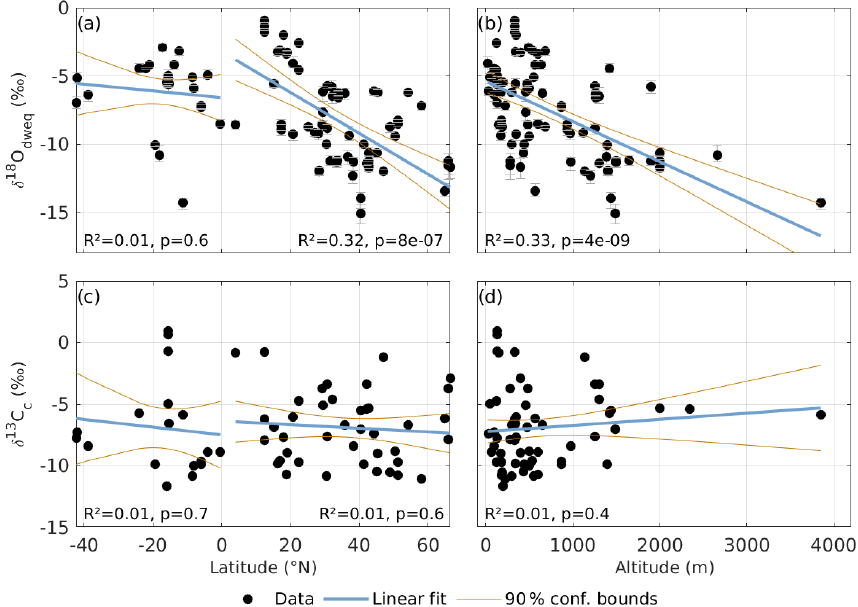
Figure 6. Speleothem δ 18 O dweq (a, b) and δ 13 C c (c, d) against latitude (a, c) and altitude (b, d) as provided by the SISALv2 database. Linear regression lines are shown separately for both the Northern Hemisphere and Southern Hemisphere in panels (a) and (c) with their respective the R 2 and p values. In panels (b) and (d) , R 2 and p values correspond to the respective linear regressions across all latitudes. Confidence bounds are